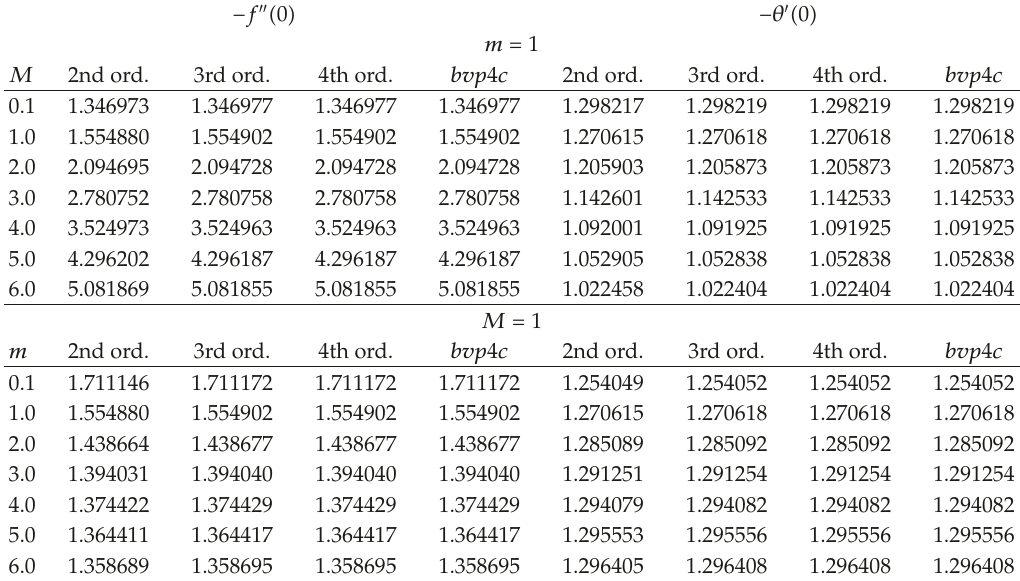
Table 2: Comparison between the present successive linearisation method (cid:6) SLM (cid:7) results and the bvp4c numerical results for − f (cid:6)(cid:6) (cid:6) 0 (cid:7) and − θ (cid:6) 0 (cid:7) for various values of M and m when Pr (cid:5) 0 . 72; M (cid:5) 1; m (cid:5) 1; S (cid:5) 0 . 8